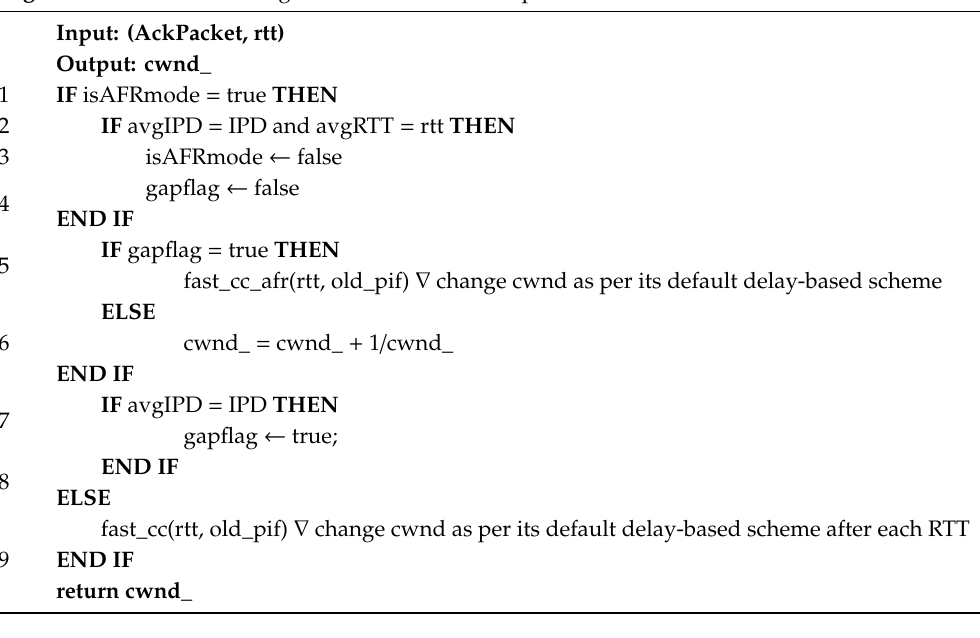
Algorithm 1. Growth of congestion window on receipt of each ACK in